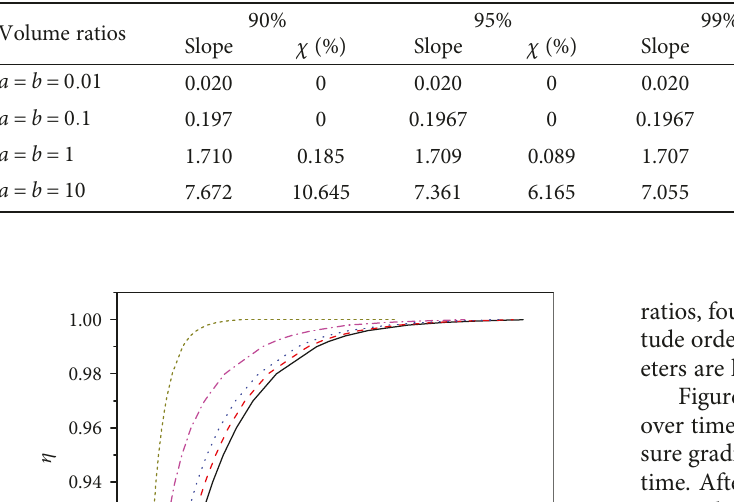
Table 1: Error coe ffi cient χ at varied η values.